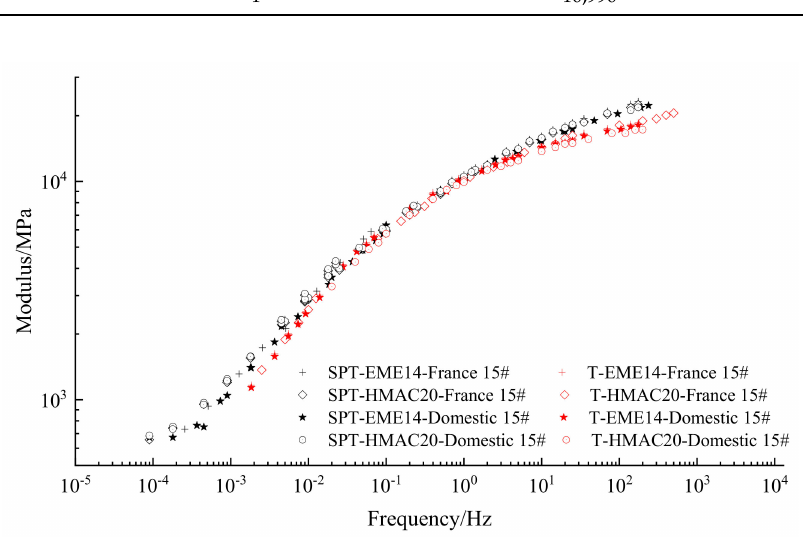
Figure 5. Modulus master curves of high-modulus mixtures with different test method. The SPT modulus master curve established based on the respective standard tempera- ture translation is higher than the CRT-2PT complex modulus master curve, which shows that the dynamic modulus obtained by the SPT test is greater than the complex modulus obtained by the trapezoidal beam test. It is mainly due to the fact that the compressed mode was used in the SPT test, while the bending-tension mode was used in the CRT-2PT trapezoidal beam complex modulus